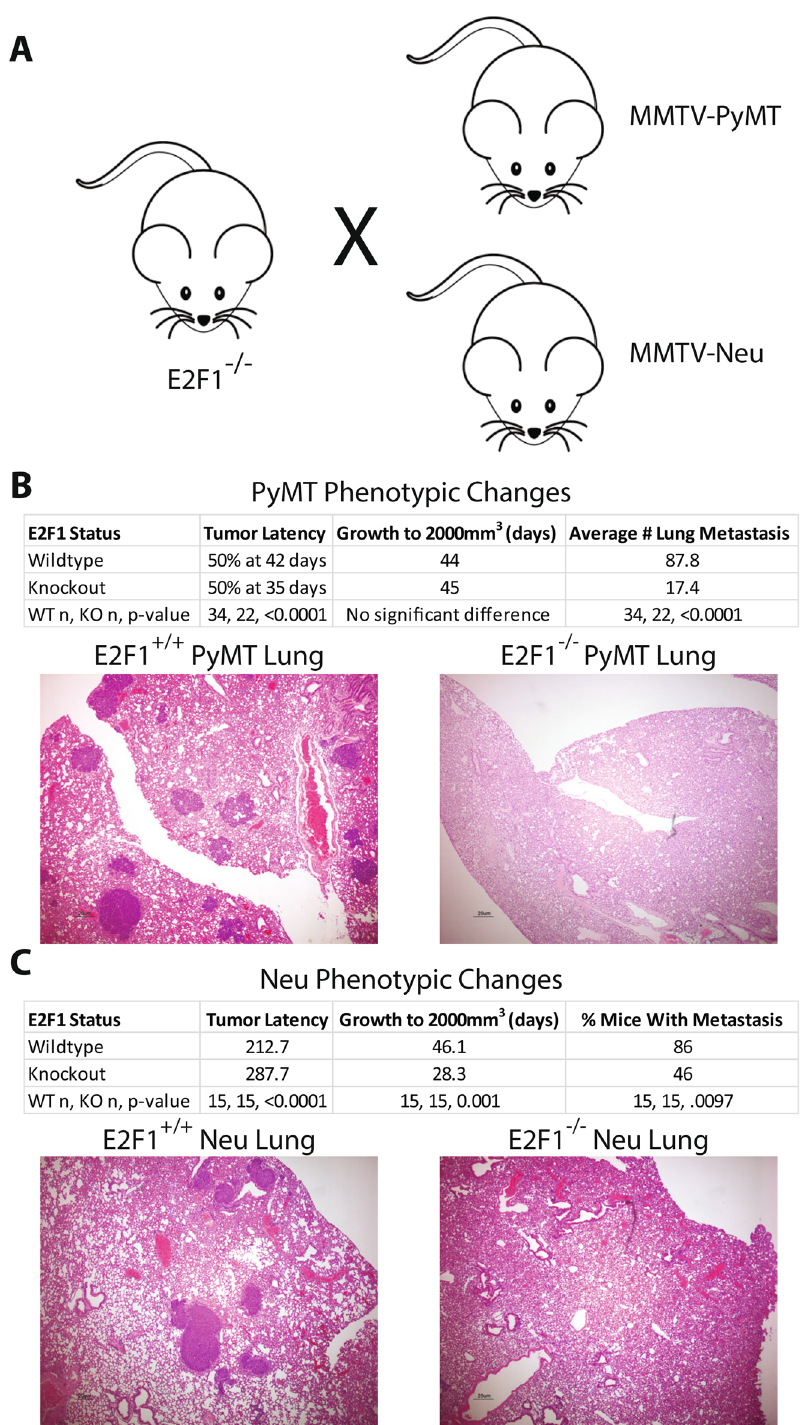
Figure 1. Altered phenotypic characteristics in E2F1 −/− tumors. ( A ) E2F1 −/− mice were crossed with MMTV- Neu and MMTV-PyMT mice on the FVB background to create E2F1 knockouts in both models. ( B ) Phenotypic changes seen in PyMT E2F1 −/− mice and ( C ) Neu E2F1 −/− mice, summarizing changes in latency, growth rate, and number of metastasis. H&E staining of E2F1 +/+ mouse lung shows a large number of metastasis, while E2F1 −/− mice have little to no metastasis. Histology of the lungs was obtained at primary tumor